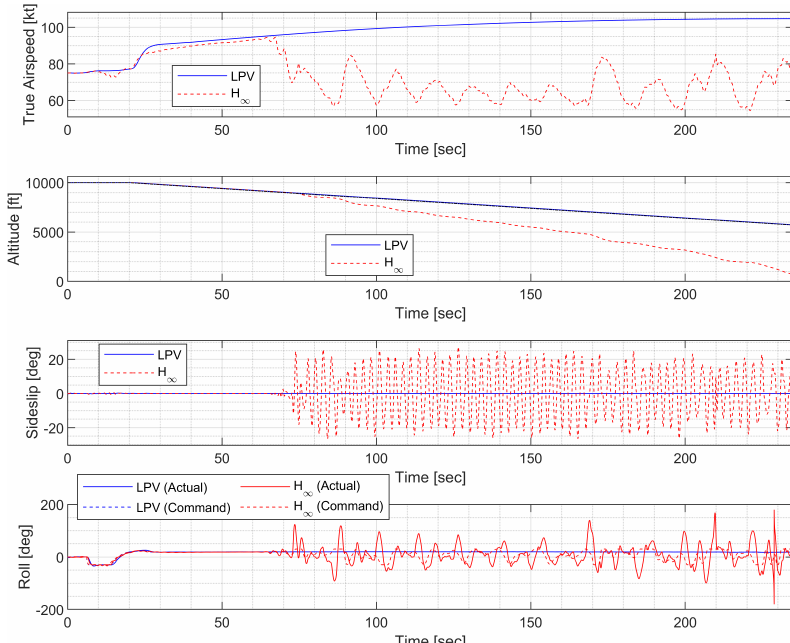
Figure 30. Statehistory of the spiral descent.